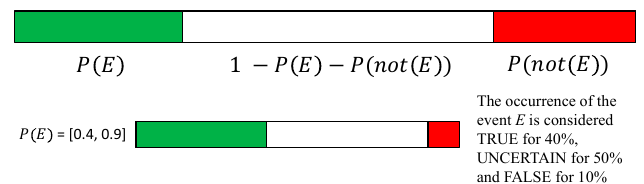
Figure 17. Three-value logic IF. This representation is for a generic proposition or event E with some examples